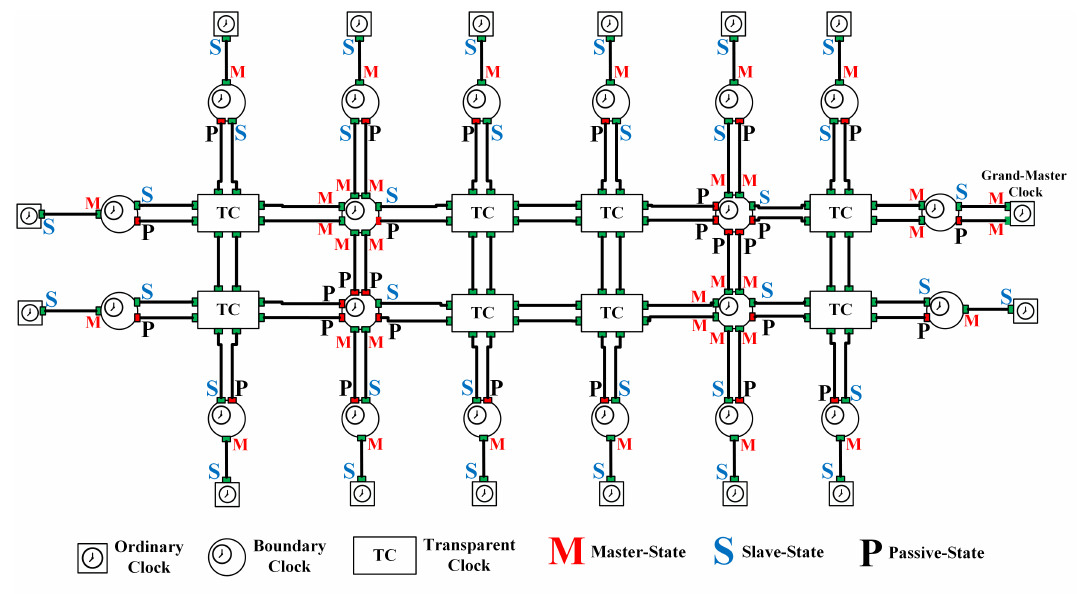
Figure 2. A sample PTP